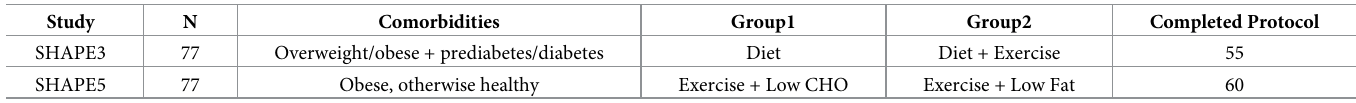
Table 1. SHAPE cohort